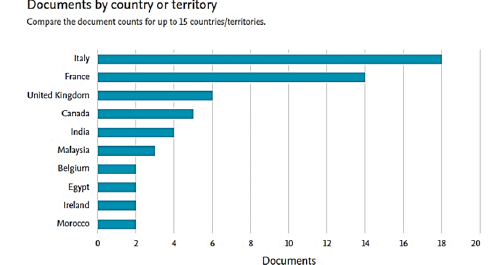
Fig. 1. Analysis and evolution of the words “brick” and “hemp” Source: Scopus scientific review